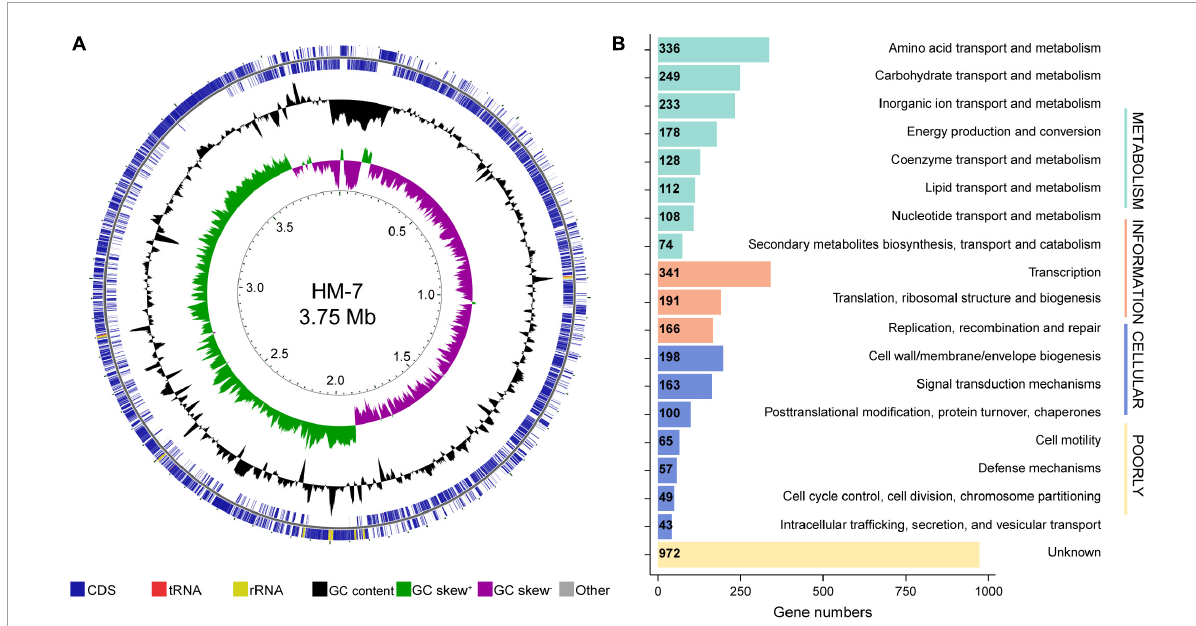
FIGURE1 Genome analysis of B. pumilus strain HM-7. (A) From the inner to the outer circle: Circle 1, genomic position; Circle 2, GC skew; Circle 3, GC content; Circle 4 and 5, predicted protein-coding sequences (CDS) transcribed anticlockwise (inner part) and clockwise (outer part), respectively. (B) COG function classification of genes in HM-7, grouped into four main parts: Metabolism, cellular processes, information, and poorly.